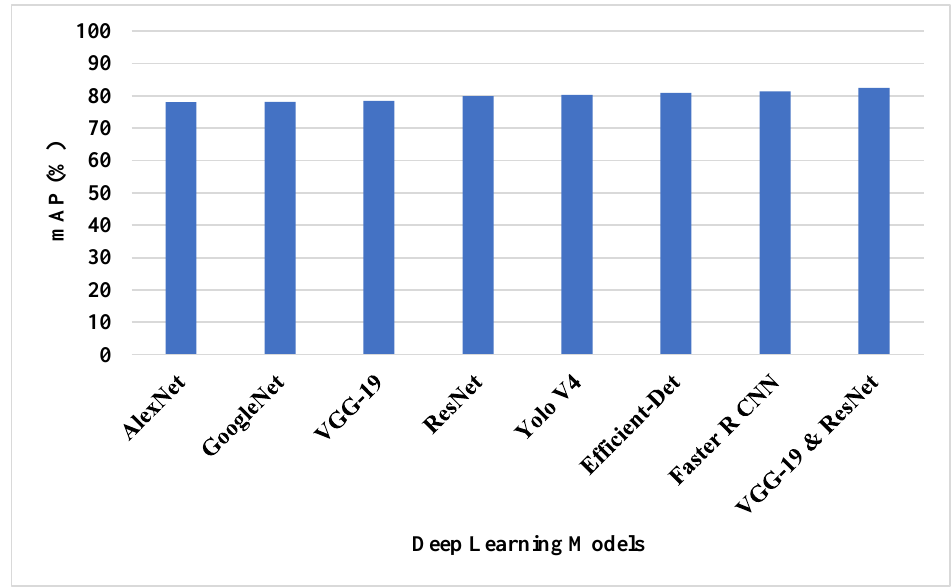
Figure 6. The mAP of deep learning techniques on DOTA dataset.